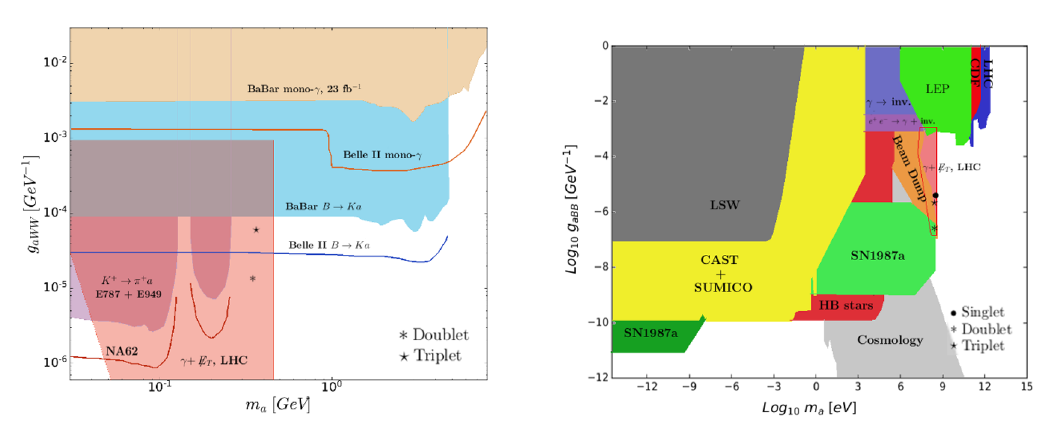
Figure 12 . In the left panel [76{84], g aW is the ALP-coupling assuming k BB = 0 with the limits taken from ref. [27]. The points represent benchmarks of the model presented in section 5. The panel at right [8, 16, 24, 31, 73, 85{88] displays the g aB coupling of the ALP where k WW = 0 and is taken from ref. [31]. In these plots, the regions that can be probed by the monopohoton channel, at 95% CL, are contained in the light red shaded areas. The points still represent the benchmark points of the UV model presented in the next section.